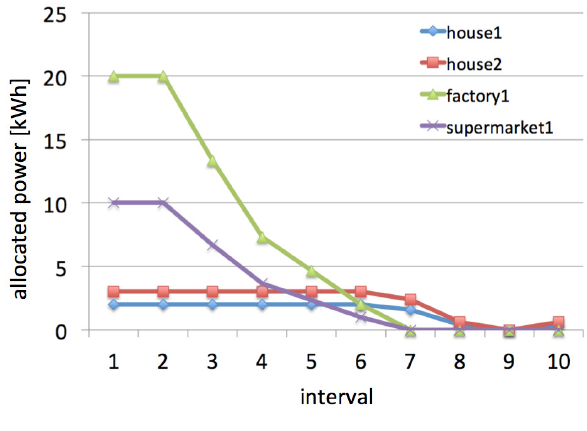
Figure 10. The transition of the power allocation.